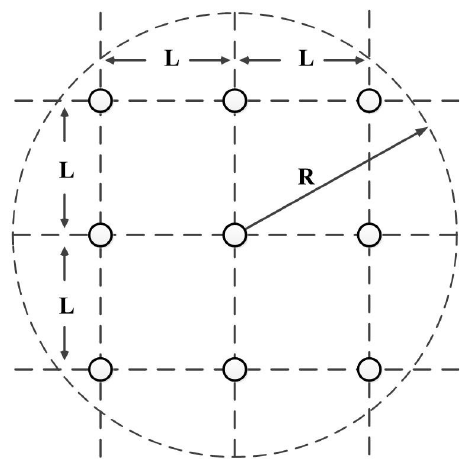
Figure 5. Network Model in Theoretical